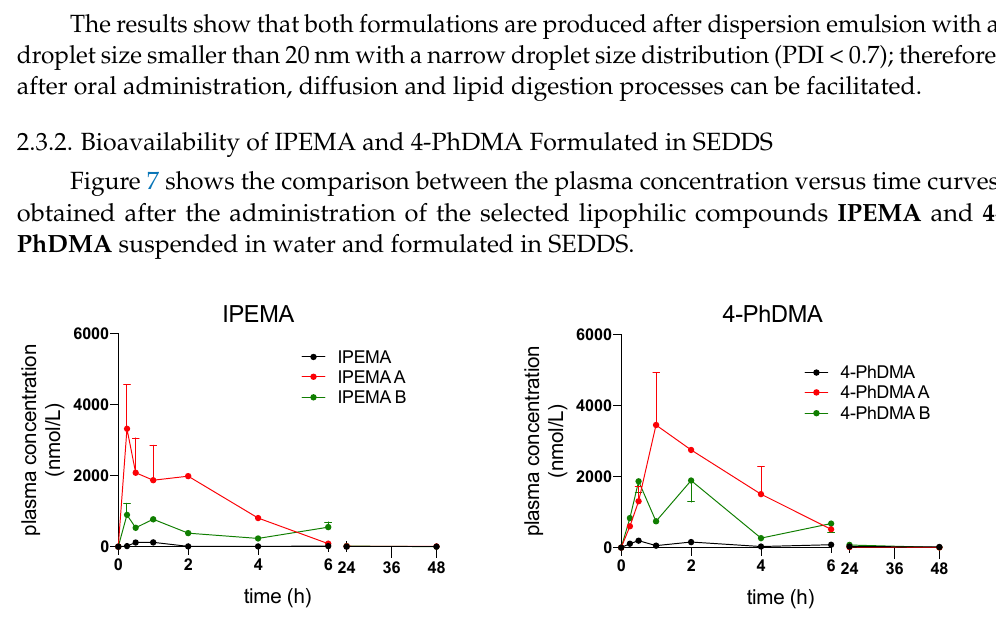
Figure 7. Plasma concentration versus time curves obtained after administration of the selected com- pounds IPEMA and 4-PhDMA , suspended in water or formulated in SEDDS to c57BL/6 male mice.